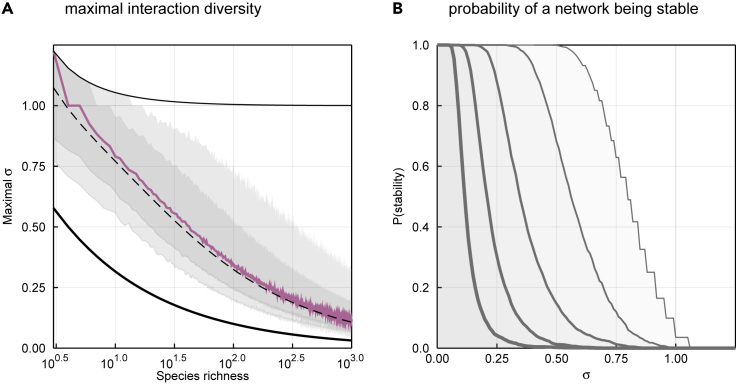
Stability Imposes a Limit on Network SizeUsing Equation 7, we can calculate the maximum standard deviation in the strength of interactions that should ensure food web stability, σ∗ = 1/√LD (A). The colored line represents the median value of maximum standard deviation, based on the posterior distribution of the flexible links model, and the gray areas cover the 78% and 97% percentile intervals. The fine and dark lines indicate the maximum and minimum values of maximum standard deviation, respectively. The dotted line shows the maximum for the average LD, as given by Equation 7. The maximum standard deviation falls sharply when the number of species increases, which will limit the stability of large food webs, and therefore explain why Eltonian demons should not emerge. In (B), we show the probability of a network with S species being stable, based on draws from the posterior distribution, for 10 ≤ S ≤ 1,000: larger networks (thicker lines) are increasingly unlikely to be stable.